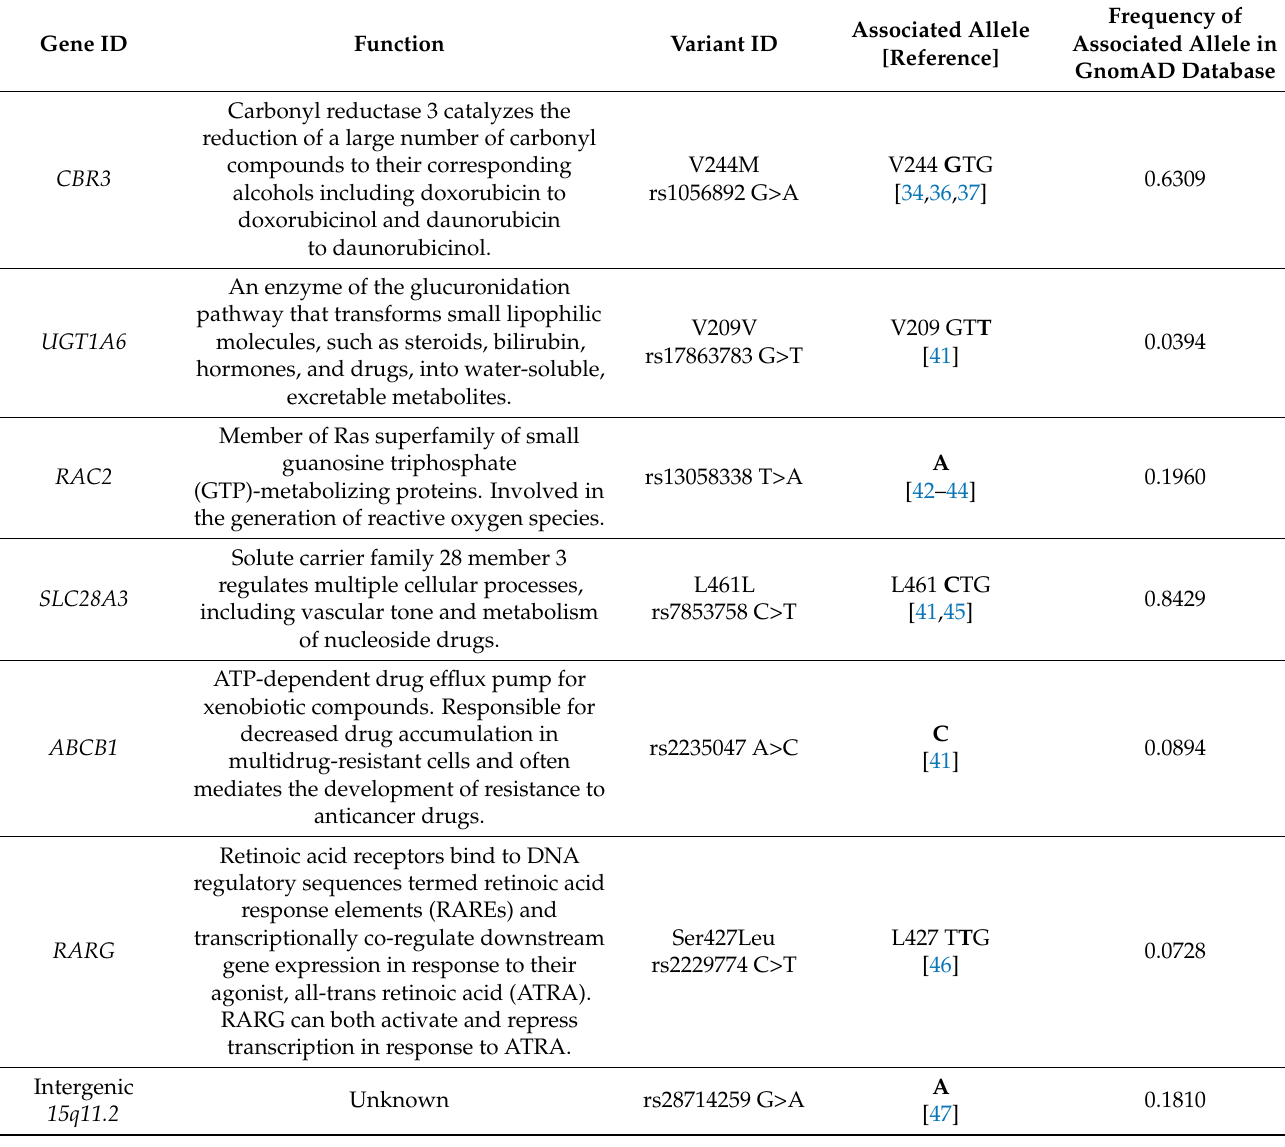
Table 1. Genes and variants associated with anthracycline-induced heart failure and the frequency of each associated variant in sequence data from >140,000 individuals in the GnomAD database. Associated allele is shown in bold. Gene ID Function Variant ID